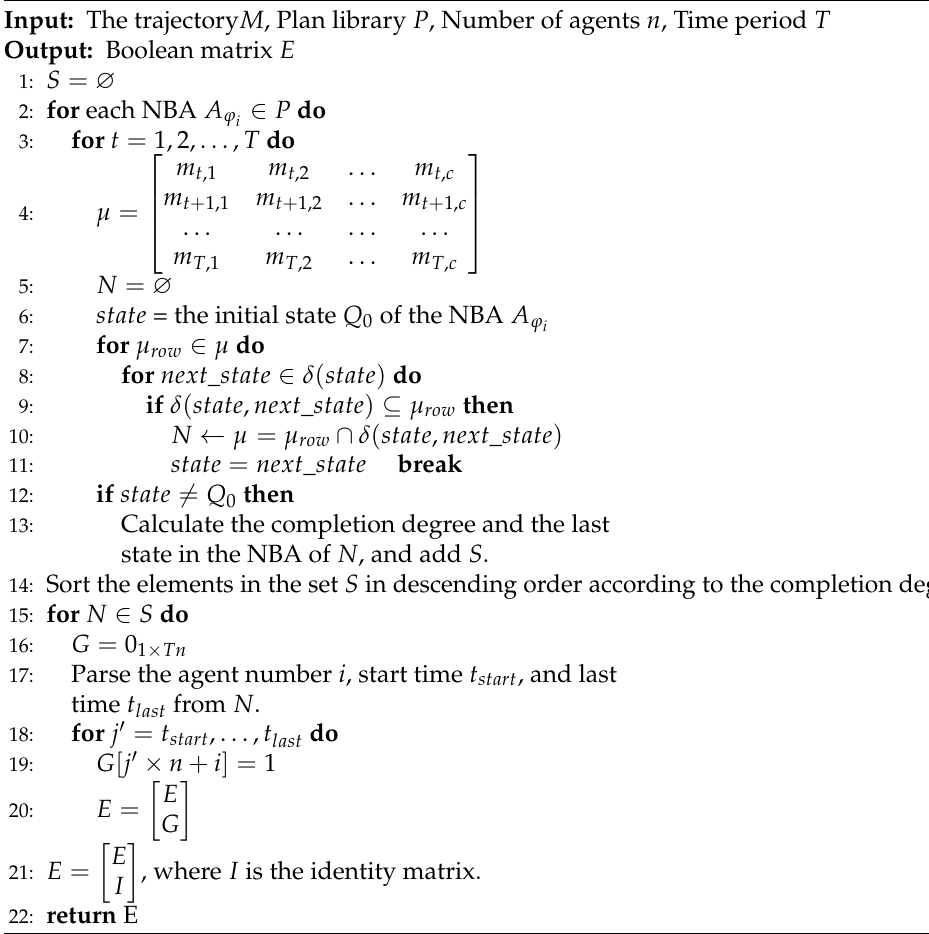
Algorithm 1 Boolean matrix generation